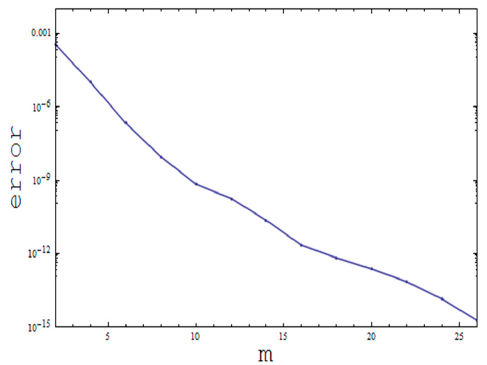
Figure 3. Results of 10th order approximations.